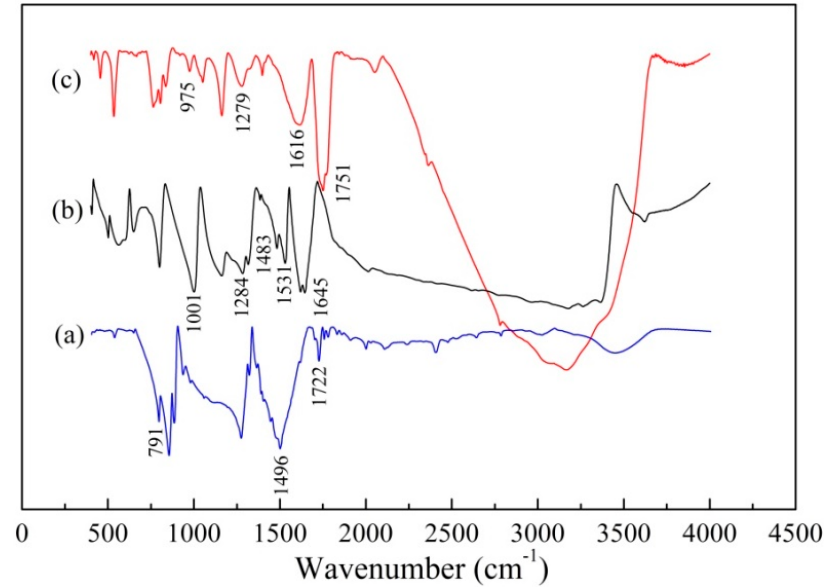
Figure 1. FT-IR spectra of cyanuric chloride (a), thiosemicarbazide (b) and TSC-CC (c).